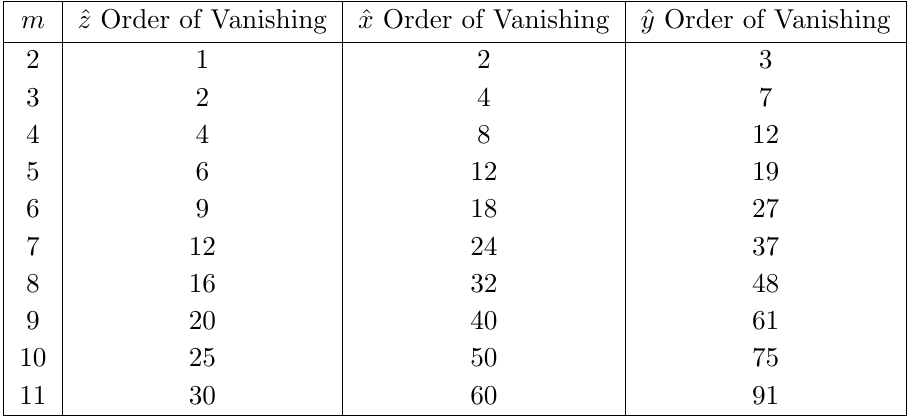
Table 8 . Orders of vanishing for the m ^ s components at f 9 = ^ f 12 = 0. These are calculated using the simpli(cid:12)ed Morrison-Park model described by equations (5.3) and (5.4). The orders of vanishing for m = 2, 3, and 4 agree with the behavior of the generating sections in models admitting q = 2, 3, and 4 matter. One can therefore conjecture that the components of sections in models supporting q = m matter would vanish to the orders listed here at the q = m